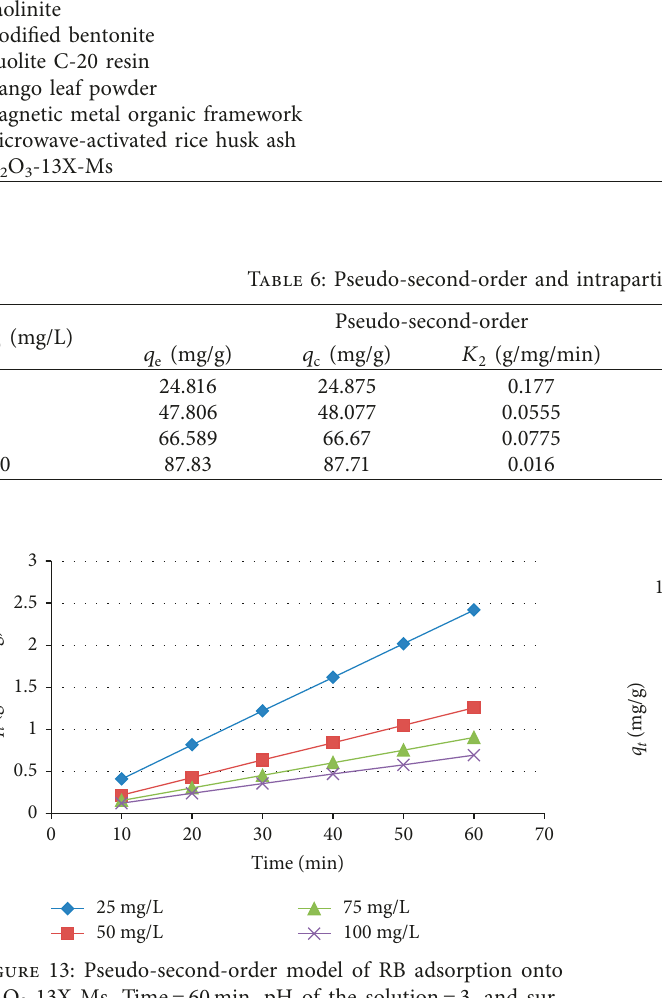
Table 5: Comparison of maximum adsorption capacity reported in extant studies with that of Fe